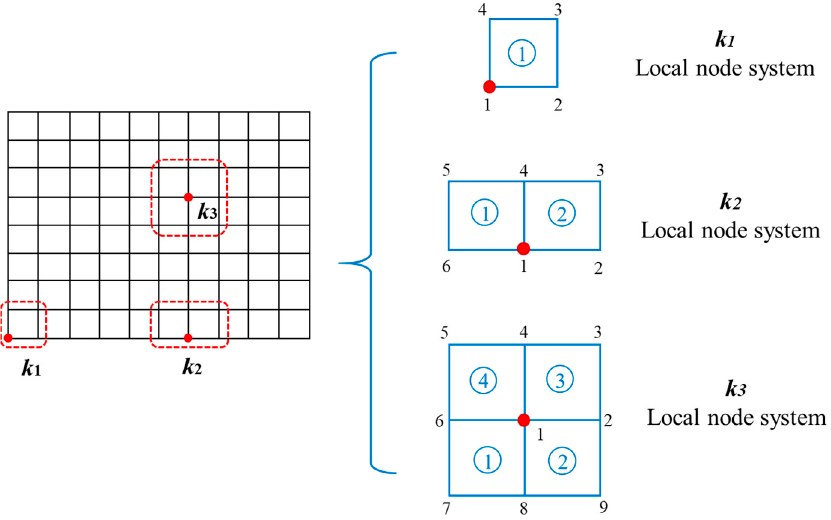
Figure 1. Local node systems.